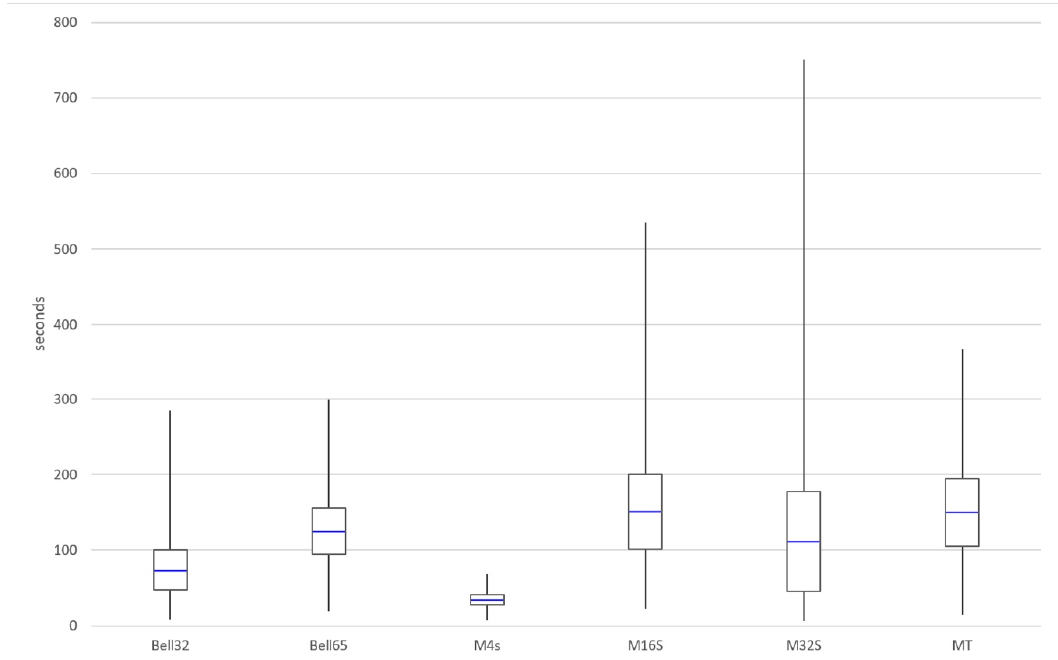
Table 7. Probability of synchronization/connection success.